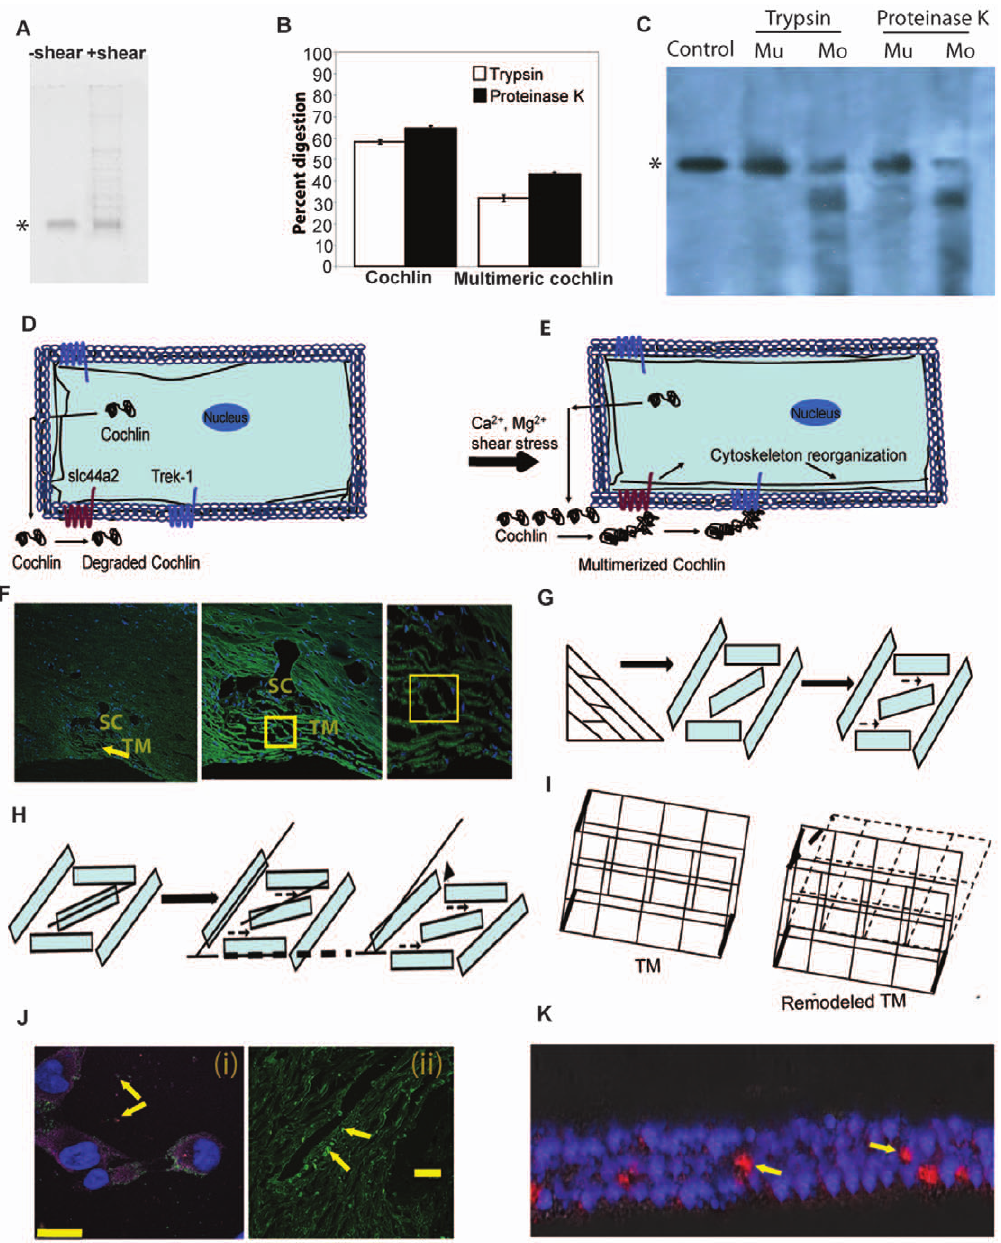
Figure 3. Cochlin mechanosensing and proposed model of potential associated TM changes. (A) Western analysis of purified recombinant cochlin (*) using anti-cochlin antibody before after sheer stress, revealing shear stress-induced mulitmers. Cochlin was subjected to fluid shear of 3 m l/min for 150 cycles. (B) Comparison of proteolytic digestion (in percentage) of native (left side) and multimerized (right side) cochlin by trypsin (open bars) and proteinase K (filled bars) showing slower digestion of multimerized cochlin. Digestion of multimerized and native cochlin (10 m g) was performed using 0.01 m g/10 m g Trypsin or 0.05 m g/10 m g Proteinase K. After incubation at room temperature, the samples were boiled using 1 mM DTT at 100 u C for 1 minute and analyzed on SDS-PAGE. Densitometric analyses data from three independent experiments (mean 6 standard deviation) has been presented. (C) A representative Western analysis of native and multimerized cochlin subjected to subcatalytic amounts of trypsin and proteinase K digestion for 10 minutes at room temperature. Purified recombinant cochlin (*), native monomeric cochlin and multimeric cochlin (initial amount 1 m g) has been depicted as Mo and Mu respectively. Digestion was performed by 0. 1 m g/10 m g Trypsin or 0.5 m g/10 m g Proteinase K. Digestion was stopped by heating at 100 u C, separated on a 10% reducing SDS-PAGE and probed with chicken polyclonal antibody against cochlin. Proposed model of cochlin mechanosensing and associated global change in TM. (D) Illustration depicting that the cochlin constitutively secreted by the normal TM cells is degraded by the proteases (dashed lines denoting degraded proteins). (E) Cochlin in the presence of fluctuating shear stress (or elevated divalent cations), forms multimers which are resistant to proteolysis. Multimerized cochlin may potentially interact with the transmembrane proteins TREK-1 or slc44a2 either directly, functionally, or indirectly leading to events that may result in cytoskeletal reorganization. (F) Confocal microscopy image showing the sieve like structure of TM (arrow). A representative area of TM with rectangular arrangement of cells is highlighted by a yellow box. SC=Schlemm’s canal; TM=trabecular meshwork. The magnified view of rectangular arrangement of cells highlighted by a yellow box also has been shown. (G) The line diagram depicts the filter like structure of the TM. A magnified view mimicking one such rectangle as in (F) with an additional cell in the middle of the rectangle has been shown. Notice the change in orientation of